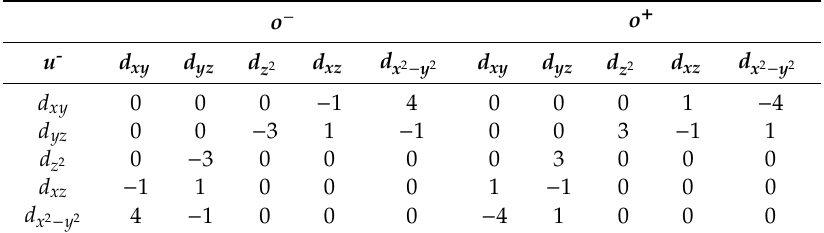
Table 2. The di ff erence of the square of the orbital angular momentum matrix elements between two directions of the magnetization in Equations (5) and